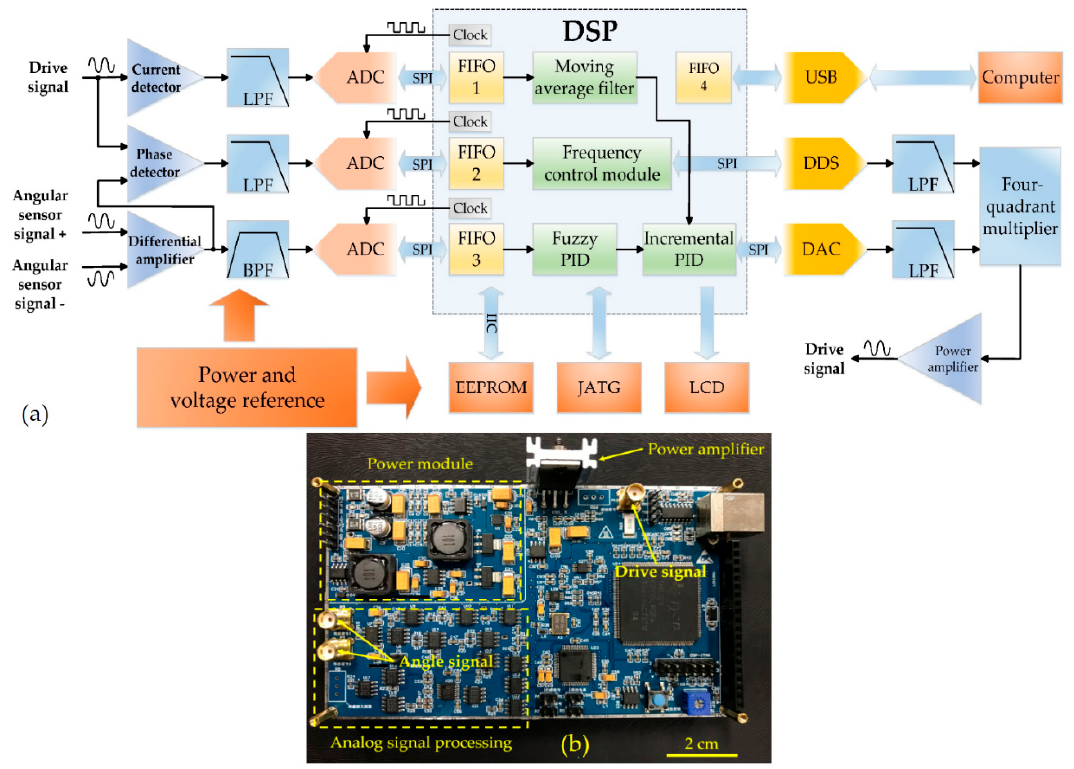
Figure 3. ( a ) Hardware block diagram of the control system; ( b ) photograph of the control circuit board.